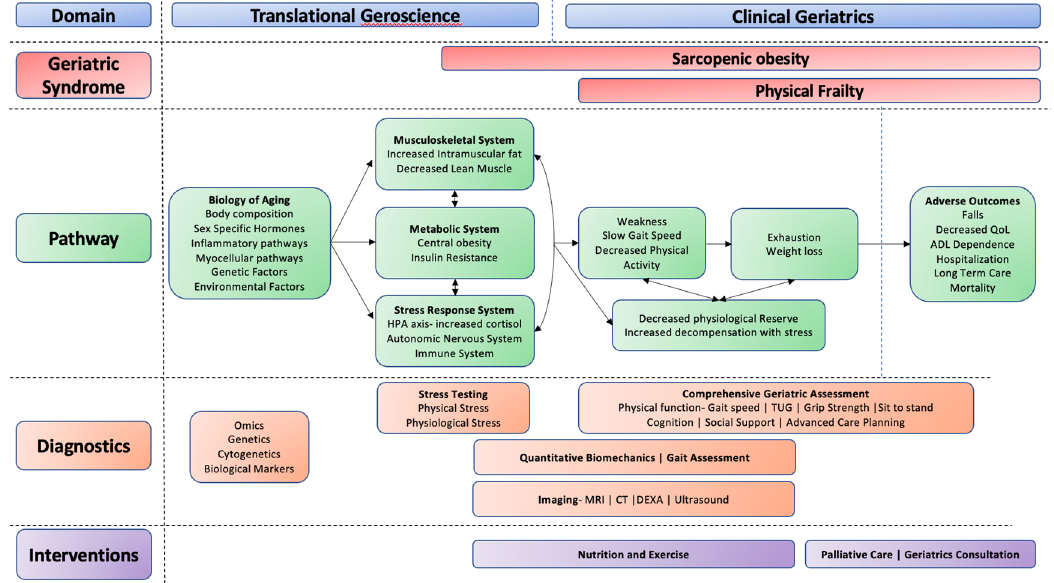
Figure 1. Geroscience conceptual model. Proposed pathways of exploration using translational geroscience (e.g., biological pathways) and clinical geriatrics (e.g., functional assessments and imaging) to identify sarcopenic obesity and physical frailty and develop targeted interventions for mitigation.